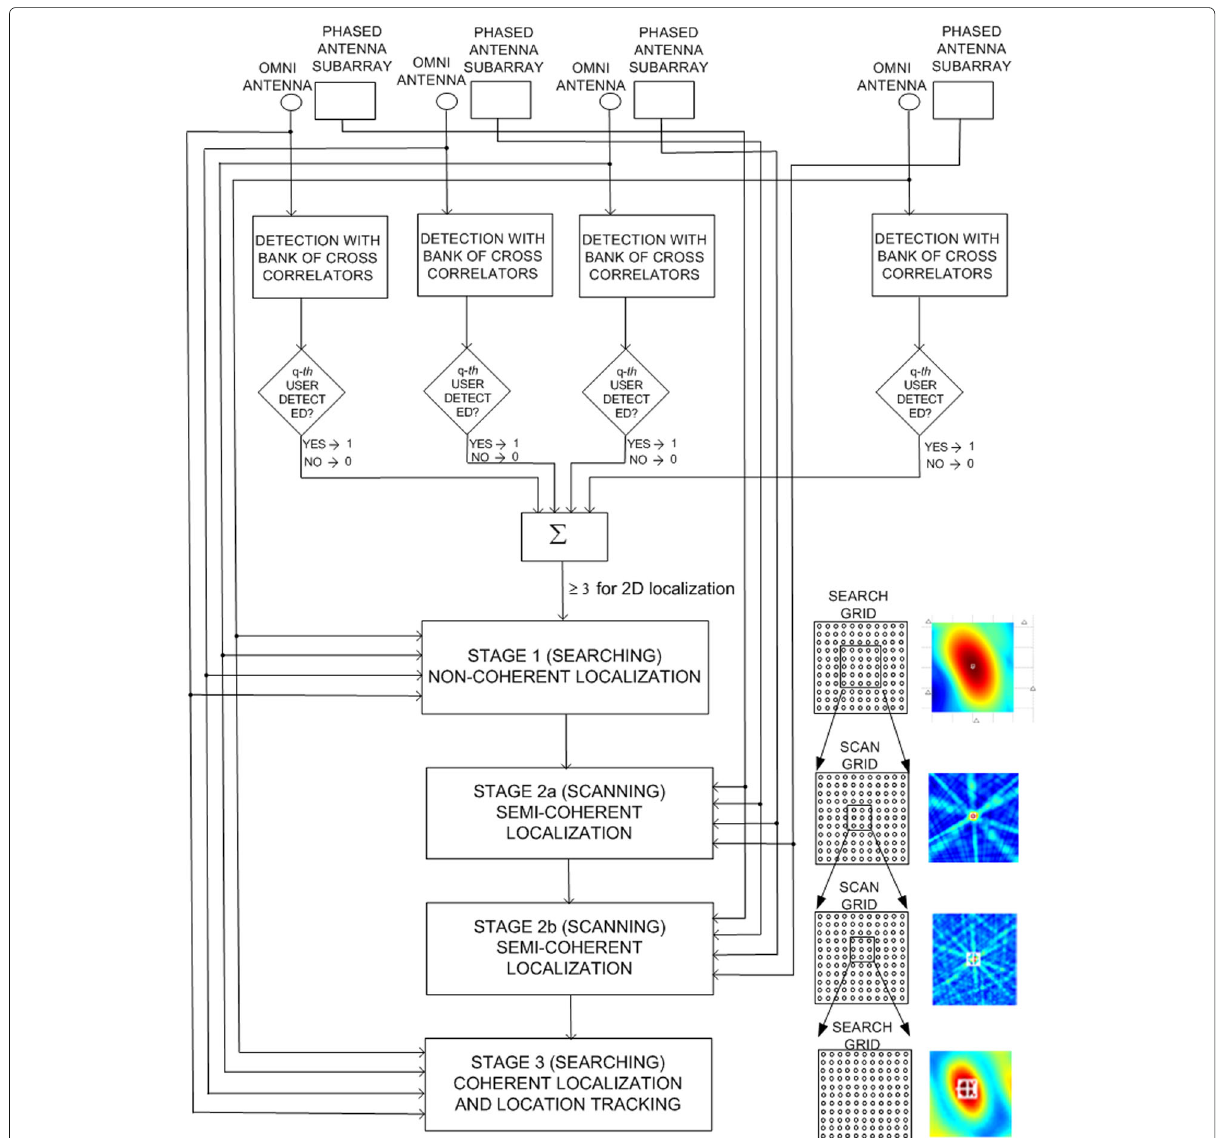
Fig. 3 The block scheme of the multistage/multiresolution search strategy